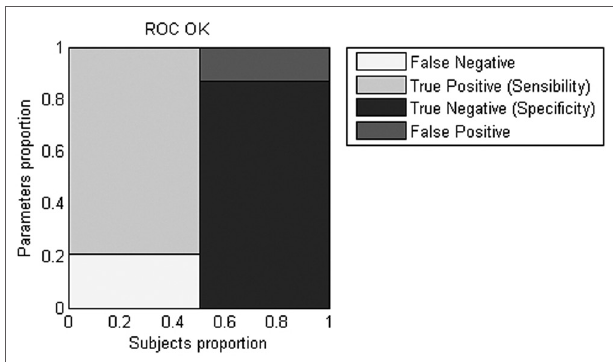
Figure 5. Graphic representation of the sensitivity and specificity cal- culated by ROC curves for the BFR with OK condition.